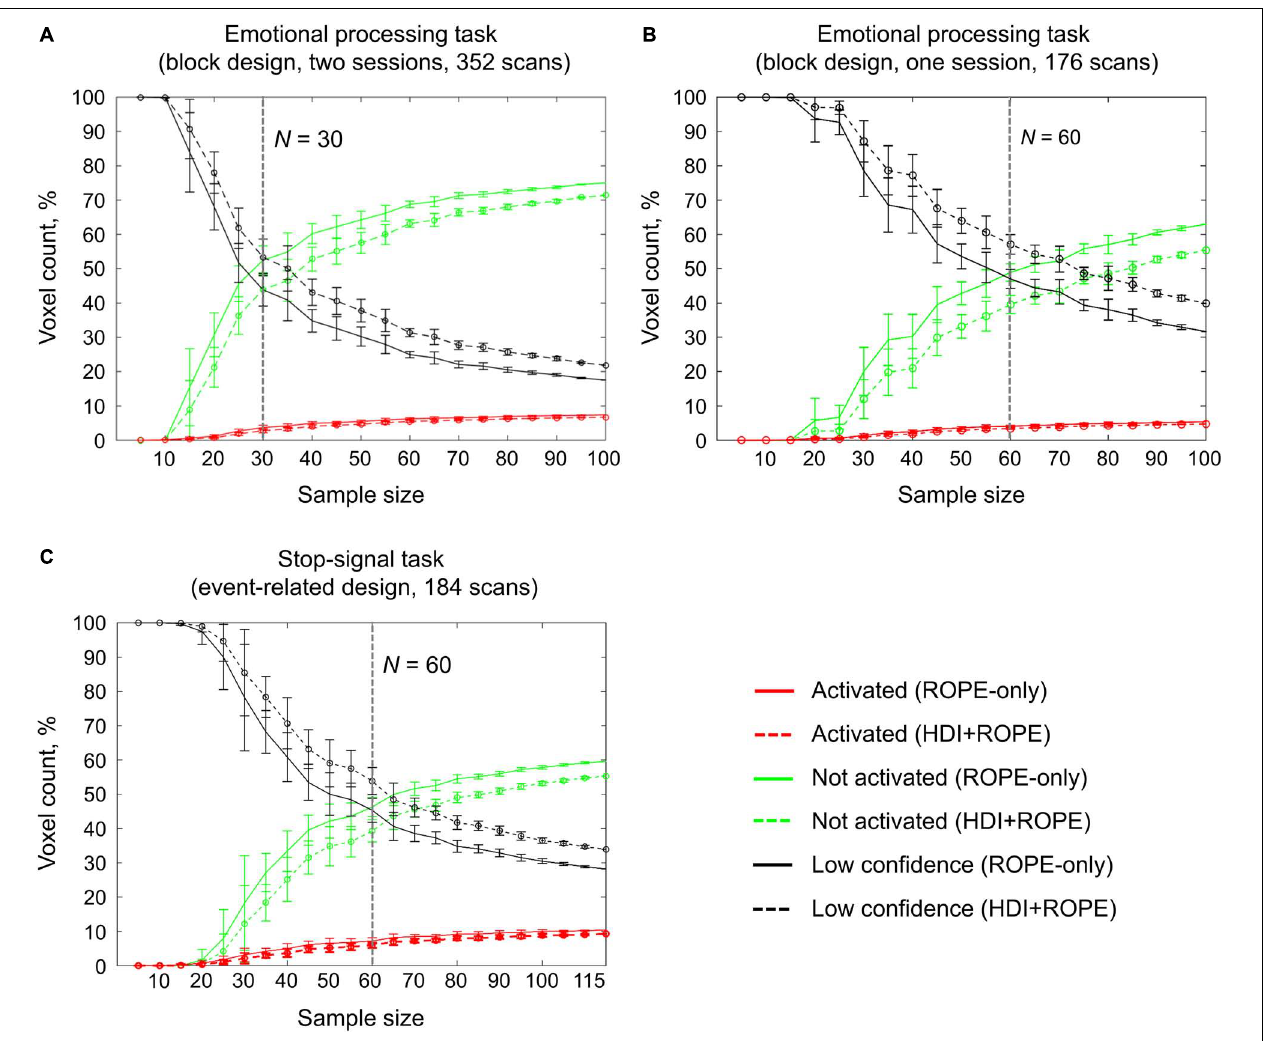
FIGURE 12 | Dependencies of the number of ‘activated,’ ‘not activated,’ and ‘low confidence’ voxels on the sample size. BPI was implemented using γ = 1 prior SD θ . (A) The emotional processing task (‘Emotion > Shape’ contrast, two sessions). (B) The emotional processing task (‘Emotion > Shape’ contrast, one session). (C) The stop-signal task (‘Correct Stop > Go’ contrast). The error bars represent the mean and standard deviation across ten random